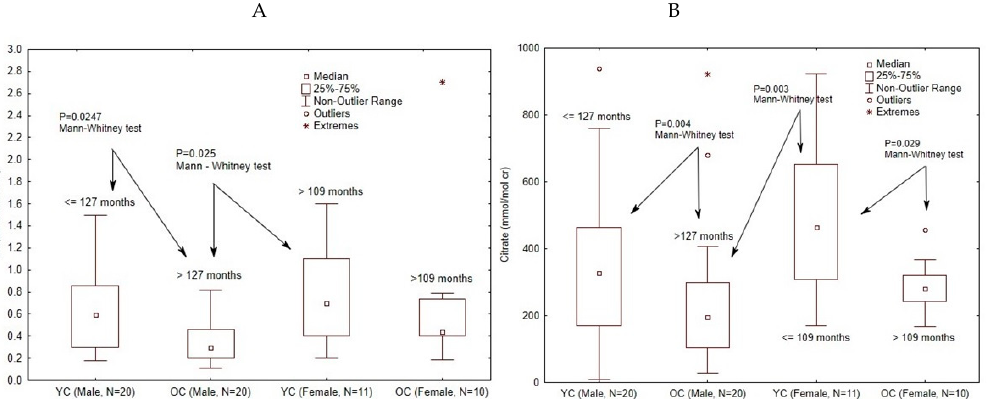
Figure 1. Possible gender differences between subgroups were tested by the Kruskal–Wallis test and Bonferroni multiple comparisons. Differences between female YC vs. OC male groups ( p = 0.008) were further test by post-hoc Mann–Whitney U test in accordance with cut-off values to our gender median (female 109 mo. and male 127 mo.). Significant differences were found for Ca (female YC vs. male OC and male YC vs. male OC) in section ( A ) and Cit excretion (female YC vs. male OC, female YC vs. female OC, and male YC vs. male OC) in section ( B ).